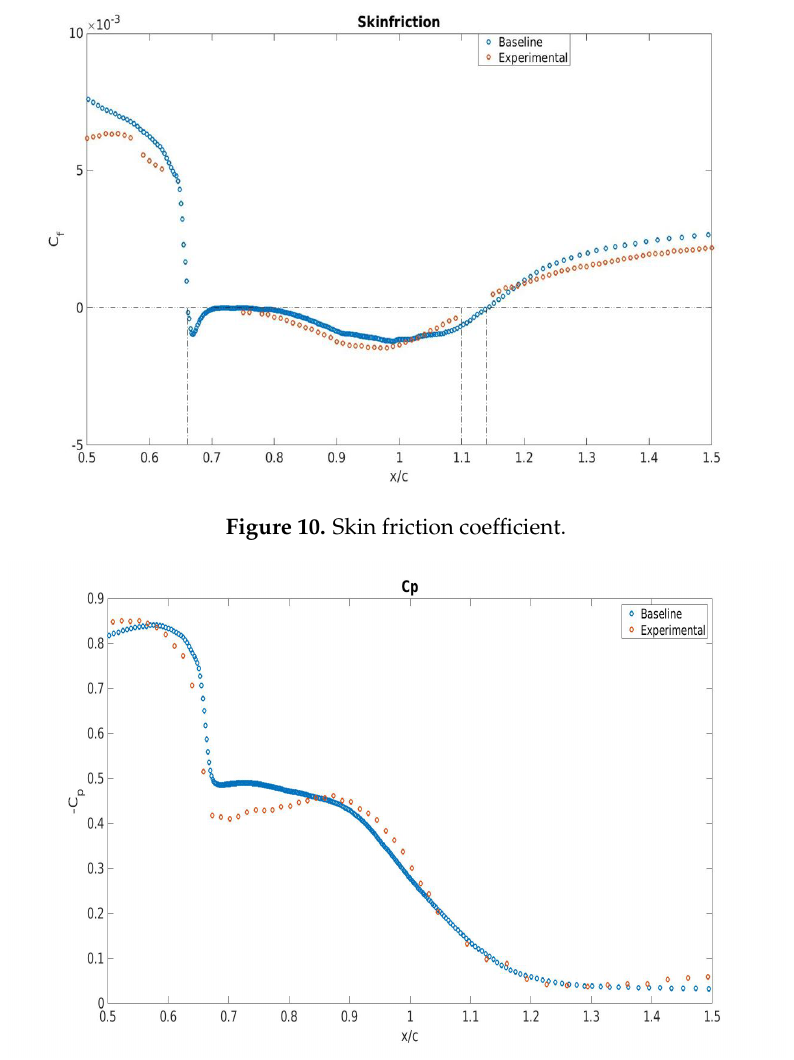
Figure 11. Pressure